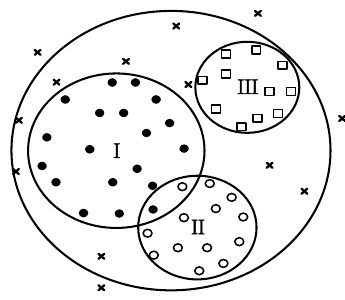
Figure 1. Schematic diagram of hyperspheres obtained by multiple SVDDs (i.e., each SVDD corresponds to one operating mode), where the symbols ( ○ , ● , and □ ) denote the corresponding samples from different modes, and the symbol (×) denotes outlier samples.